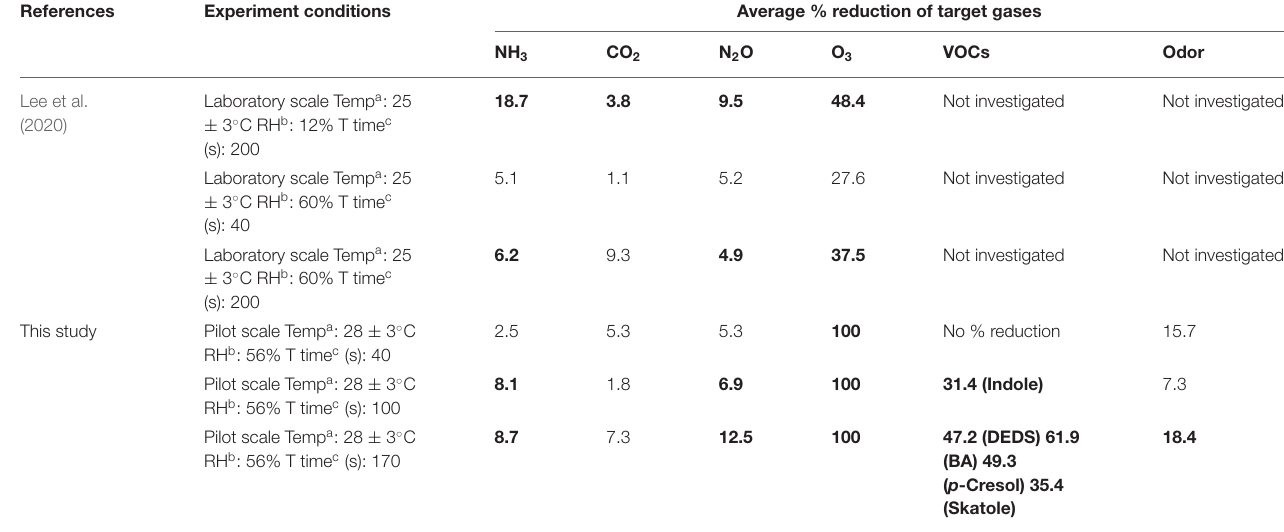
TABLE 8 | Percent reduction of target gases with UV-A photocatalysis in the poultry farm